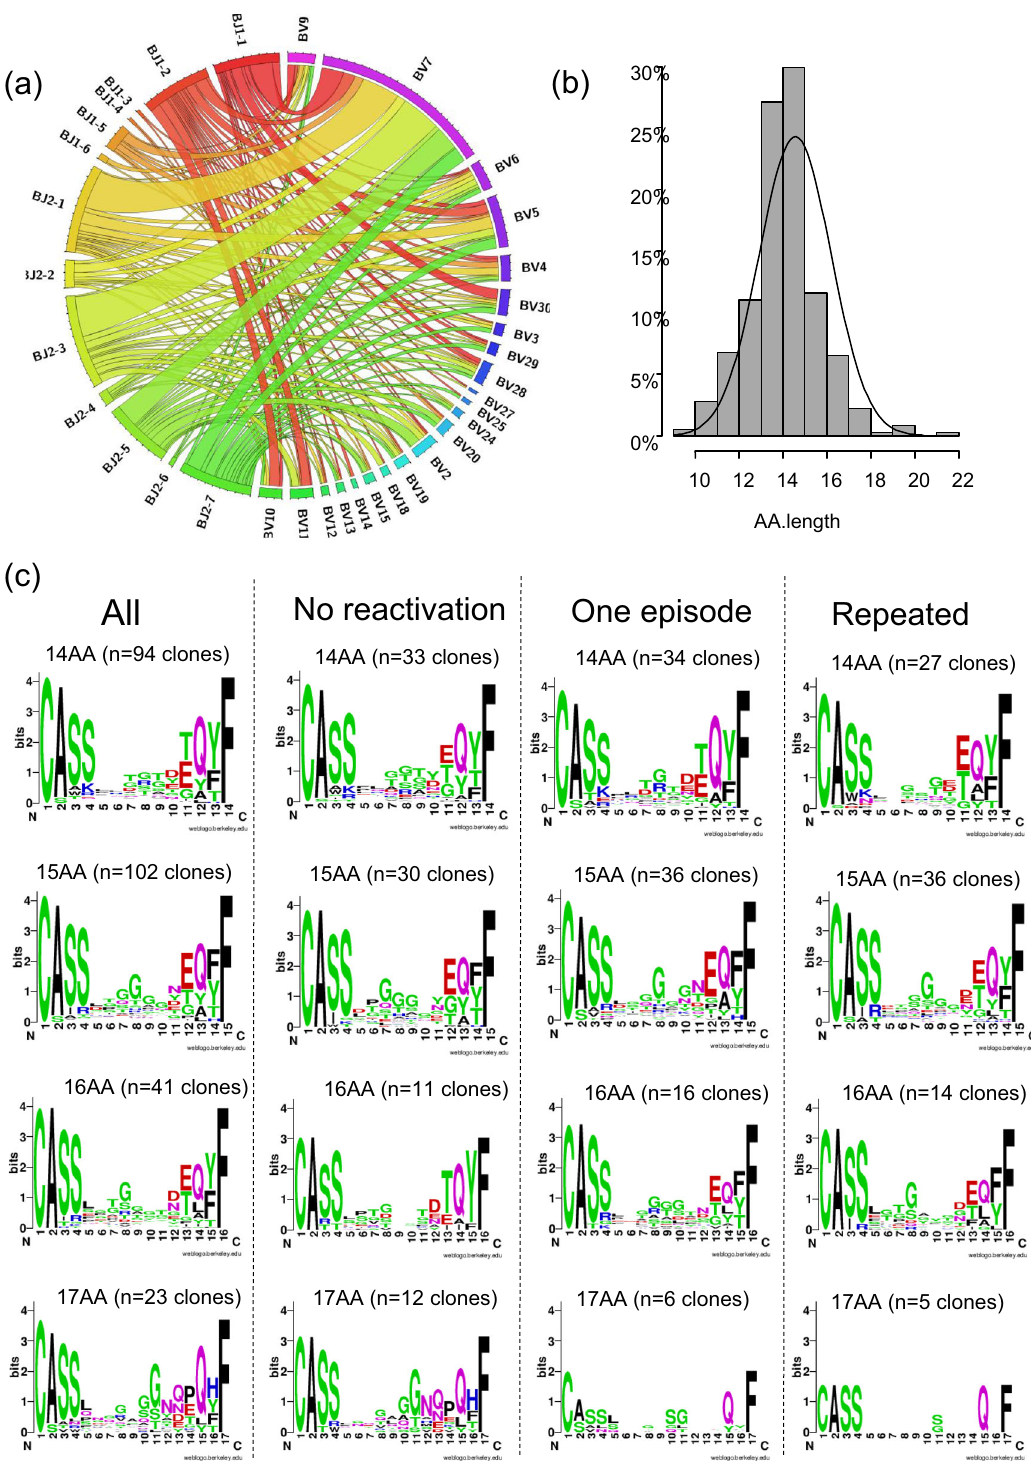
Fig. 1 Preference in the selection of complementarity-determining region 3 (CDR3) of T cell receptor (TCR)- β of all identi fi ed HLA-A24-restricted CMV-pp65-speci fi c cytotoxic T-cell (CMV-CTL) clones. a A circos plot showing a skewed preference in the selection of BV and BJ genes of all CMV-CTL clones. b A column chart for the amino acid (AA) length of all CMV-CTL clones. c AA sequence logos in all CMV-CTLs observed after allo-HCT with 17, 16, 15, or 14 AA-long TCR β -CDR3, and logos in the groups divided according to AA length and CMV reactivation pattern ( n = 10 in the no-CMV reactivation group, n = 9 in the one-episode group, and n = 7 in the repeated-CMV reactivation group). X-axis denotes the position of amino acids from the N- to C-